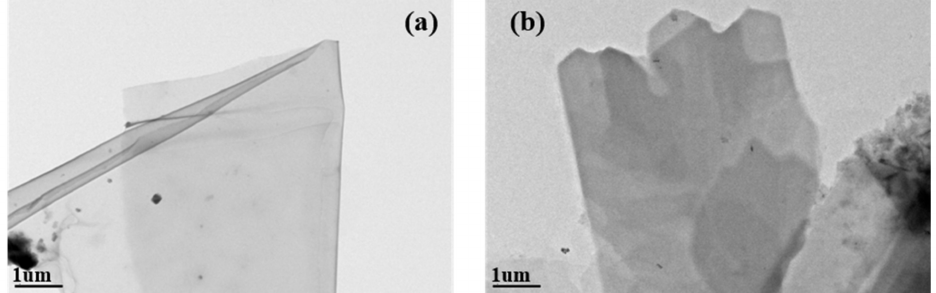
Figure 6. TEM of GO and PSG: ( a ) GO; and ( b )